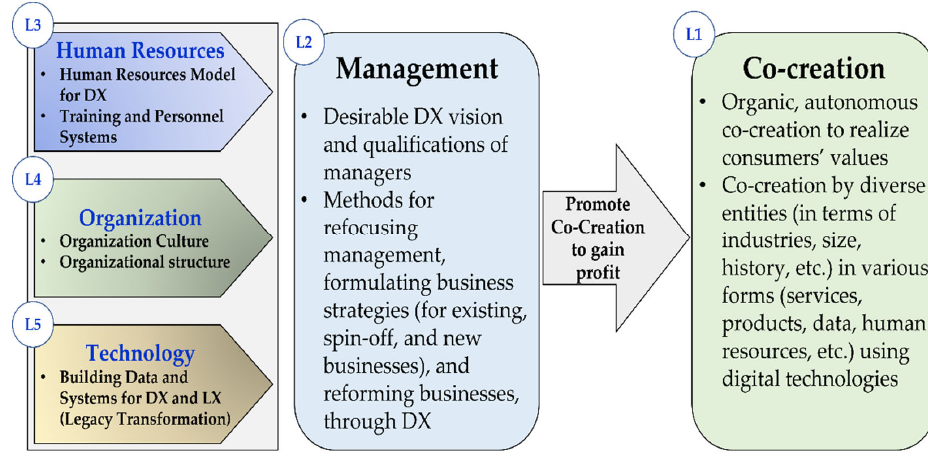
Figure 10. Overview of Corporate DX.